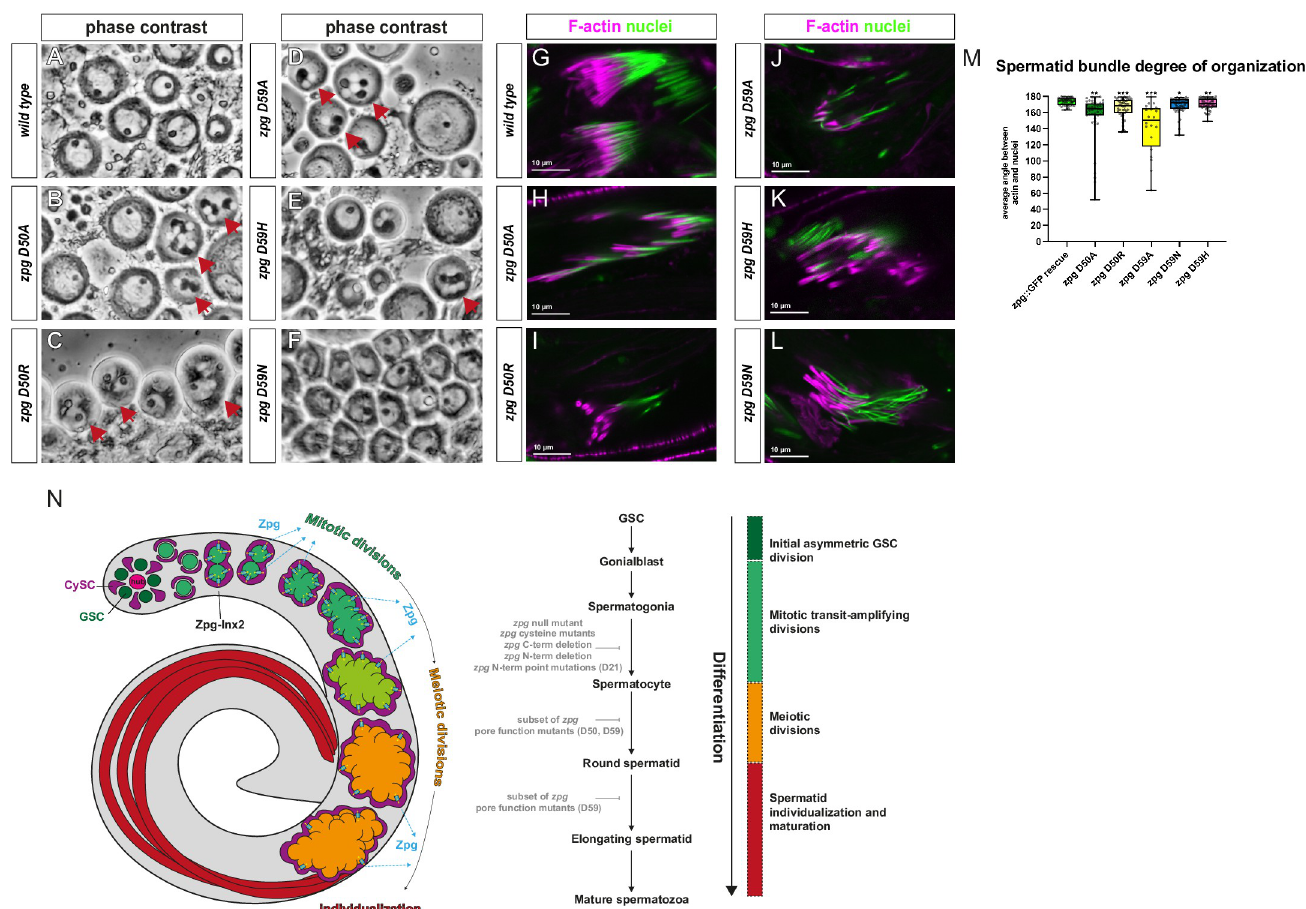
Fig 8. Defects in the spermatid stage are detected in a subset of zpg channel pore mutants. (A-F) Phase contrast imaging of “onion stage” spermatids in live testes in wt and in the subset of zpg mutants that show intermediate germline differentiation defects. In the wildtype (A), spermatids appear as round cells with large nuclei with a small nebenkern (black dot inside nuclei). Major defects such as multinucleation and abnormal nucleus-to-nebenkern ratios are seen in spermatids of zpg mutants rescued with the D50A (B), D50R (C), D59A (D), and D59H (E) mutant zpg genomic rescue constructs, as indicated by red arrows. Spermatids of zpg D59N mutants (F) do not show nuclear defects. (H-L) Spermatid individualization complexes (ICs) in testes of freshly eclosed flies were stained with rhodamine phalloidin (labels actin cones, magenta) and TO-PRO-3 (labels nuclei, green). In the wildtype (H), the actin cones are tightly associated with the elongated nuclei of 64 developing spermatids. In testes of zpg D50A (H), zpg D50R (I), zpg D59A (J), zpg D59H (K) and zpg D59N (L) mutants, the association of actin can be disrupted and the overall IC structure appears disorganized. Scale bars indicate 10 μ m. (M) Quantification of the angle of association between the actin cones and the nuclei in ICs. The wildtype has a 180˚ angle between the actin and the nuclei due to the linear organization of the IC. In all analyzed mutants, but in particular in zpg D50A and zpg D59A, the angle is smaller, indicating disorganization. n = 45 for all mutants except zpg D59A (n = 25 due to lower abundance of spermatid bundles). (N) Simplified model summarizing of the function of Zpg during spermatogenesis. Zpg is required for all major developmental transitions in fly spermatogenesis. Schematic depicts the process of spermatogenesis starting at stem cell the stem cell niche at the apical tip of the testis and ending at differentiated mature sperm (GSCs, dark green; CySCs and cyst cells, magenta; hub; pink). The gap junction (cyan) consisting of Zpg and Inx2 is found at the soma-germline interface and allows bi-directional passage of cargo (yellow arrows) between soma and germline. Soma-germline communication is required for the first, mitotic steps of germ cell division, as zpg null mutants fail to enter the transit-amplifying stages. Zpg-mediated soma-germline communication is also required in later stages of germ cell differentiation, since germ cells in hypomorphic zpg mutants generated in this study failed to enter and properly execute meiosis and/or spermatid individualization. The different stages of spermatogenesis are indicated by a colour code (Green: early stages, yellow: mid stages, red: late stages).